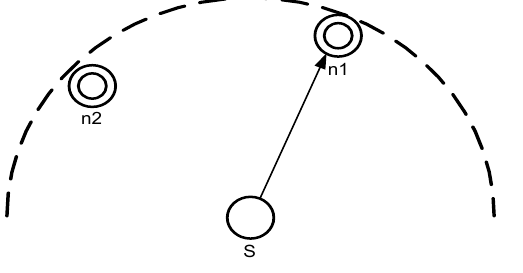
Figure 3. Neighbor node of lower pressure level has high priority to be selected as the next hop